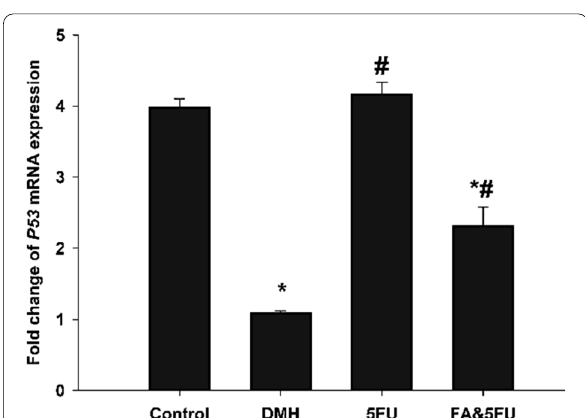
Fig. 8 Intensity percentage quantitative measurement for positive Ki67, Ck20, Caspase 3, and P53 immune reactions. Values are mean SD at p 0.05. *, significance against control. #, significance ± ≤ against DMH group